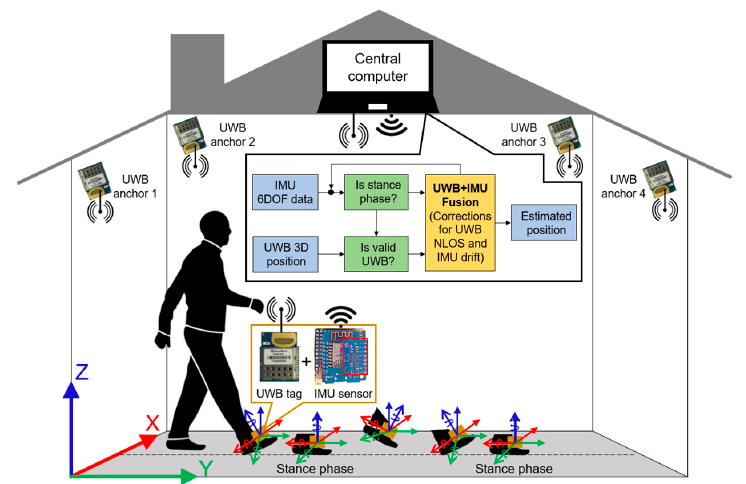
Figure 1. Block diagram of a low-cost foot-placed UWB and IMU fusion-based indoor pedestrian system.